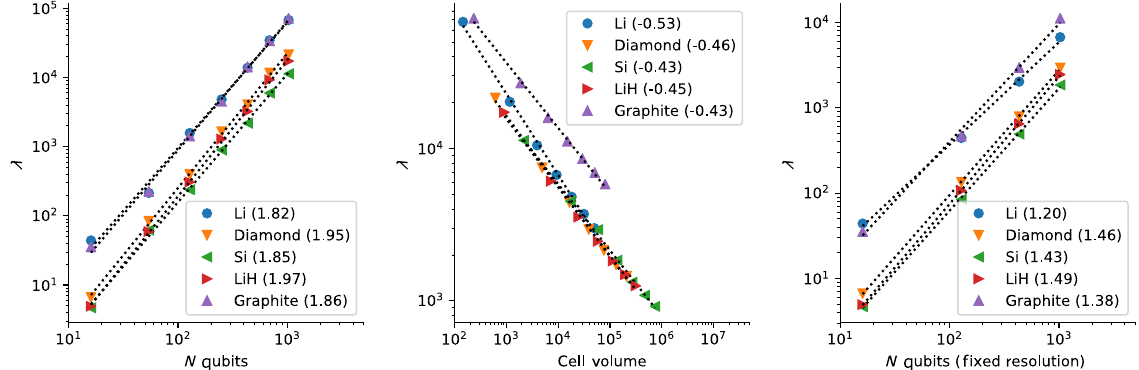
FIG. 18. Left panel: A plot ofthe λ value forone unitcell ofthe listed material near equilibrium bond length asafunction ofthe number of qubits used to discretize the cell. A plane-wave dual basis is used with an equal number of points along each of the axes. The value given after the material name corresponds to the best-fit scaling for that particular material. The materials display roughly similar scaling in λ as a function of the number of qubits. Center panel: A plot of the λ value as a function of the cell volume for a fixed number of qubits, 1024 in this case. We observe that fixing the number of qubits while increasing the cell size tends to decrease λ as expected. Right panel: A plot of the λ value as afunctionof the number of qubits, where the supercell size isscaled proportionallytothe numberofpoints alongeachaxis.In this case, two basis functions are used along each axis in the unit cell, which is scaled proportionally as the cell volume